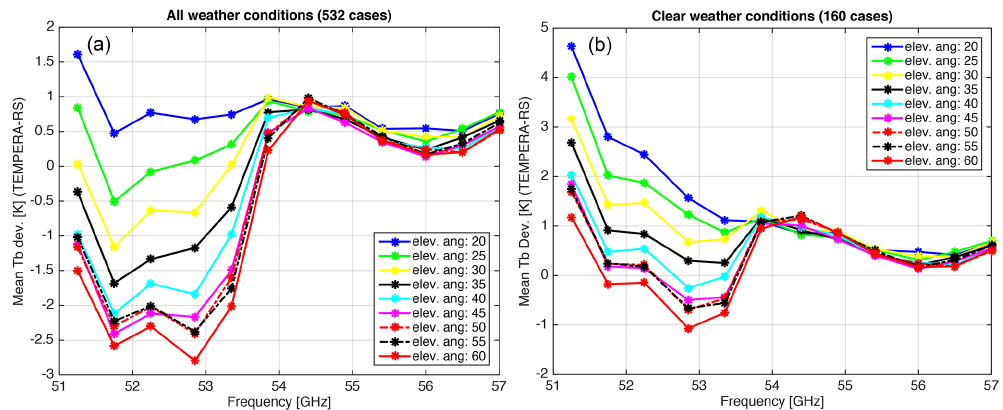
Figure 4. (a) Mean Tb deviation between TEMPERA and RS for all weather conditions (532 cases). (b) Mean Tb deviation between TEMPERA and RSs, only for clear conditions (160